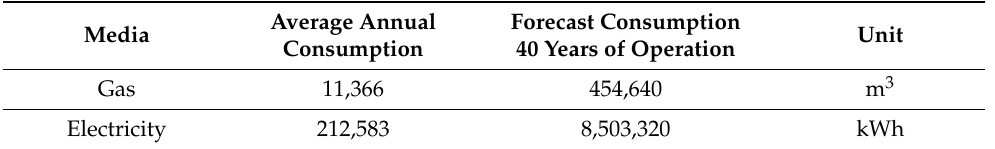
Table 1. Average annual and total forecasted consumption of utilities for the research object [own study based on the investor’s